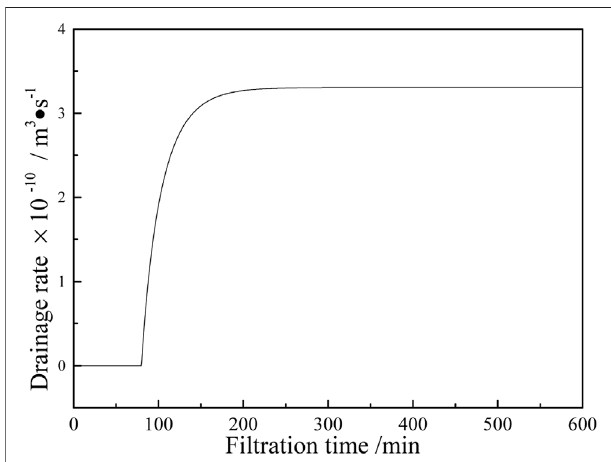
FIGURE 4 | Change of drainage rate in dynamic fi